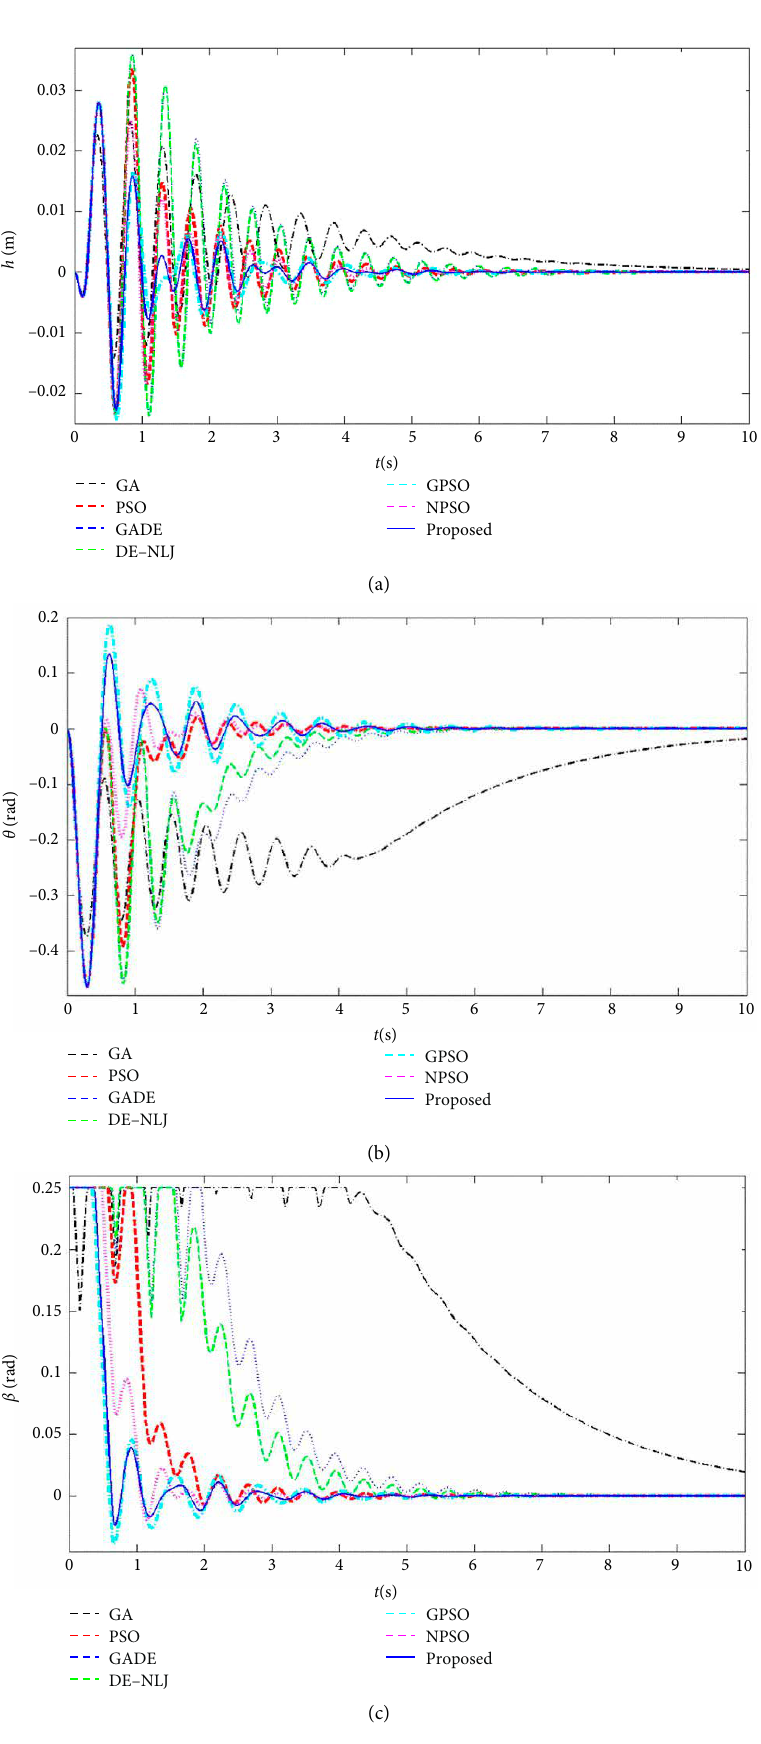
Figure 5: Comparison of (a) plunging response, (b) pitch response and (c) control effort obtained by GA, PSO, NPSO, GPSO, DE–NLJ, GADE and GNPSO based IMC-PID control of linear wing vibration